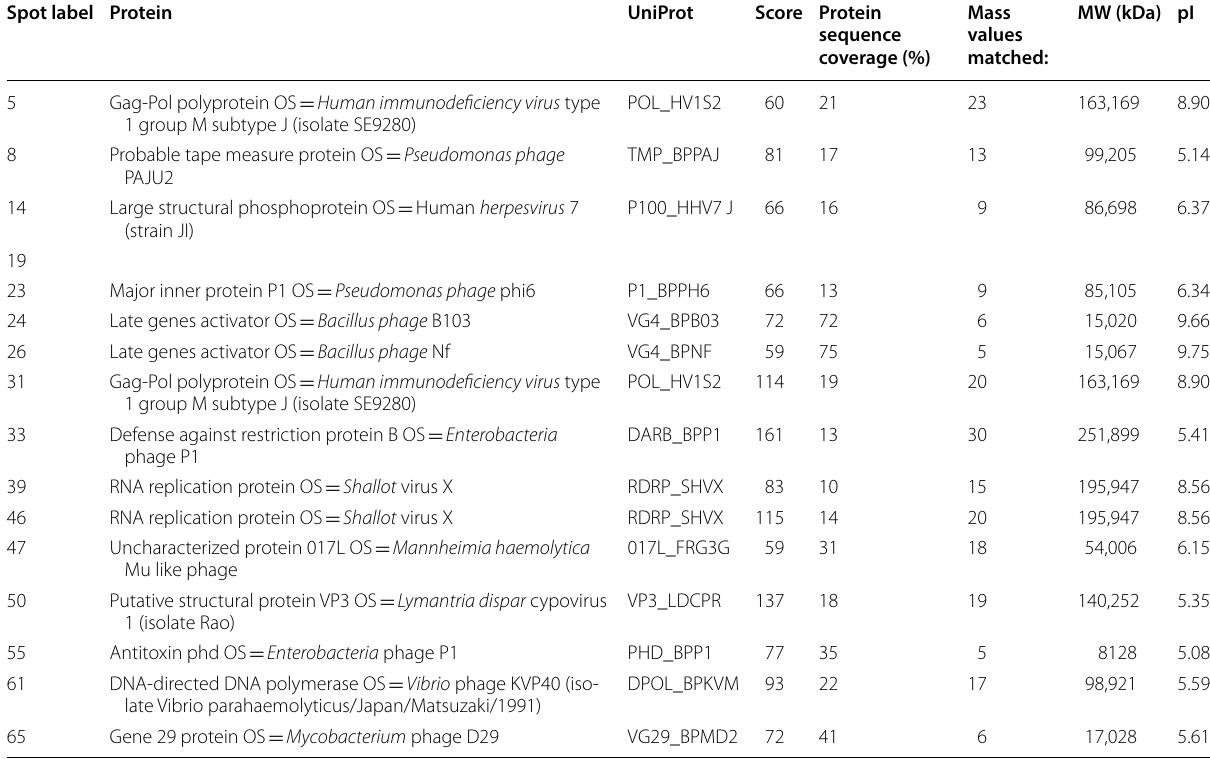
Table 1 The MALDI-TOF identification of selected common spots obtained from various phages specific for M. haemolytica strains Spot label